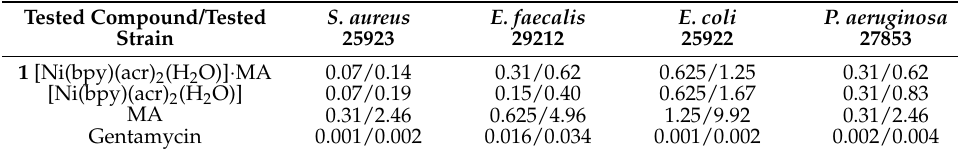
Table 3. The MIC values [(mg/mL/mM)] of the tested compounds. Tested Compound/Tested